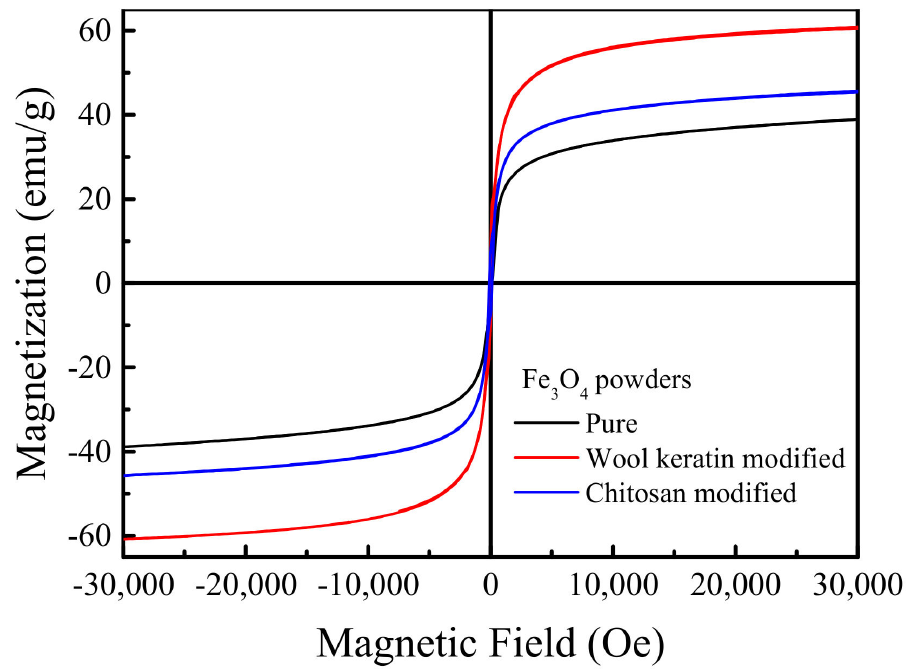
Figure 5. Magnetization curves of the pure, wool keratin modified, and chitosan modified Fe 3 O 4